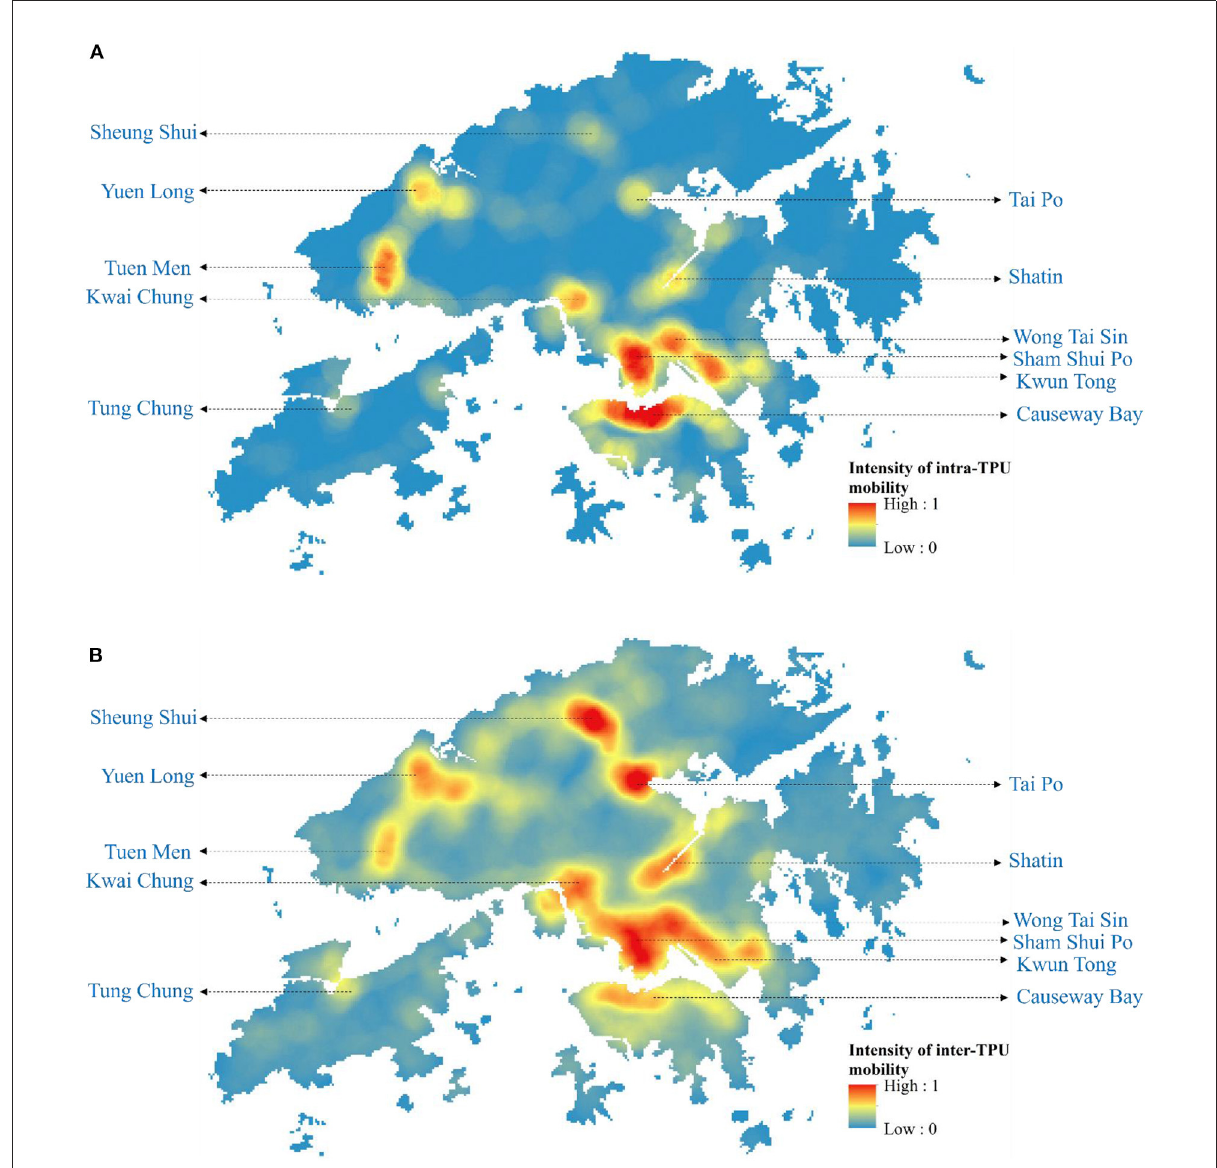
FIGURE4 The intensity of intra-TPU and inter-TPU mobility of Hong Kong from December 2021 to February 2022. (A) The intensity of intra-TPU mobility of Hong Kong. (B) The intensity of inter-TPU mobility of Hong Kong.